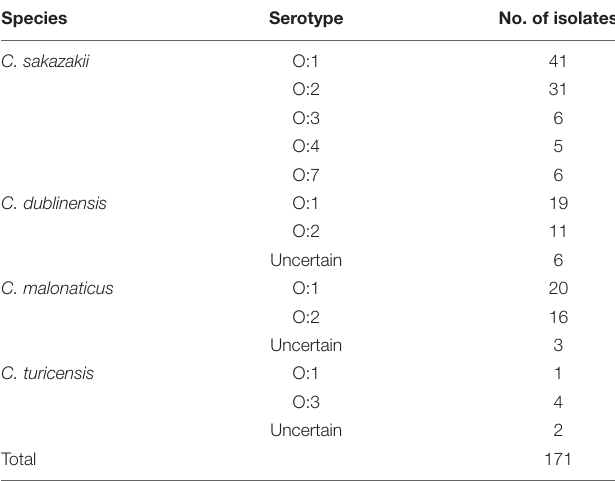
TABLE 4 | Species and serotypes of Cronobacter spp. isolates in this study. Species